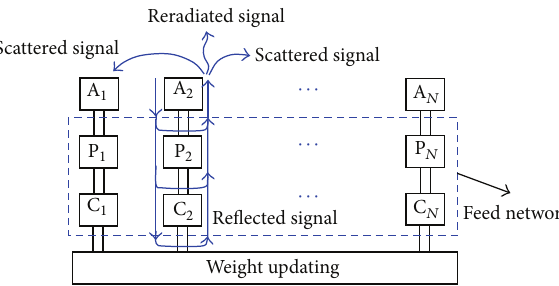
Figure 1: Schematic of adaptive antenna array.